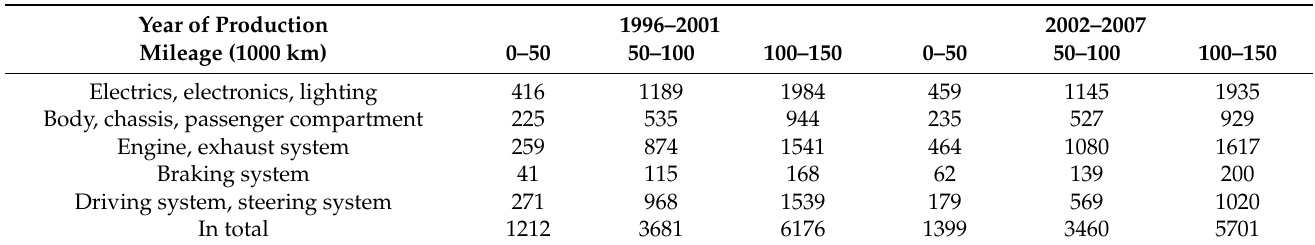
Table 10. Energy input in MJ related to the failure rate of units for remanufactured parts in a passenger car depending on its mileage and production